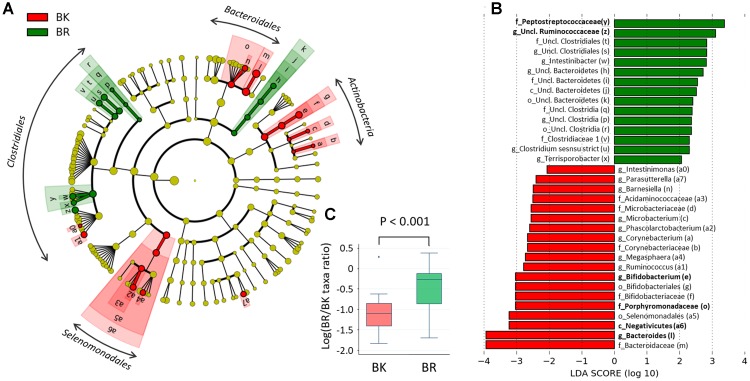
Linear discriminant analysis effect size (LEfSe) analysis to identify differences in abundant taxa between Bangkok and Buriram samples. (A) Cladogram showing different abundant taxa between samples from Bangkok and Buriram (LDA score > 2.0, p < 0.1). Alphabets correspond to those in parentheses in (B). (B) Taxonomic groups showing LDA scores > 2.0 with p < 0.1. p, phylum; c, class; o, order; f, family; g, genus. (C) Boxplot showing the distribution of the log-ratios of the BR/BK taxa ratio. The significance of difference between two cities was examined by the Wilcoxon rank-sum test. Effect size and power of this statistical analysis were calculated to be 1.01 and 0.88, respectively, by post hoc analysis. Refer to Figure 1D for a description of the box plot.